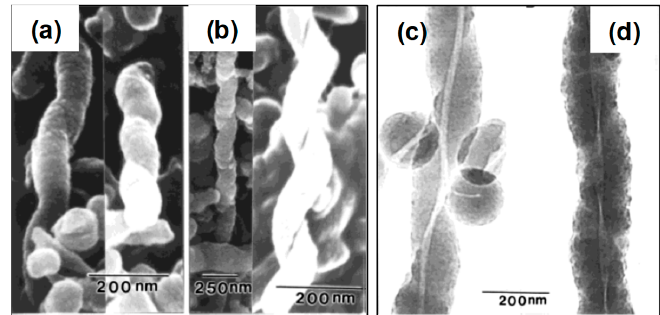
Figure 6. SEM and TEM micrographs of the silica obtained by sol-gel transcription in ( a , c ) left-handed 26 + 27 (1:1 wt%), and ( b , d ) right-handed 28 + 29 (1:1 wt%) organogels. Reproduced with permission from Reference